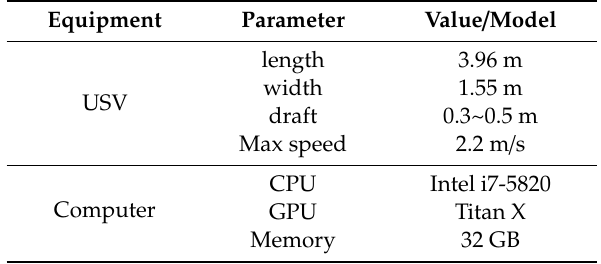
Table 1. Parameter of the experimental USV and computer.